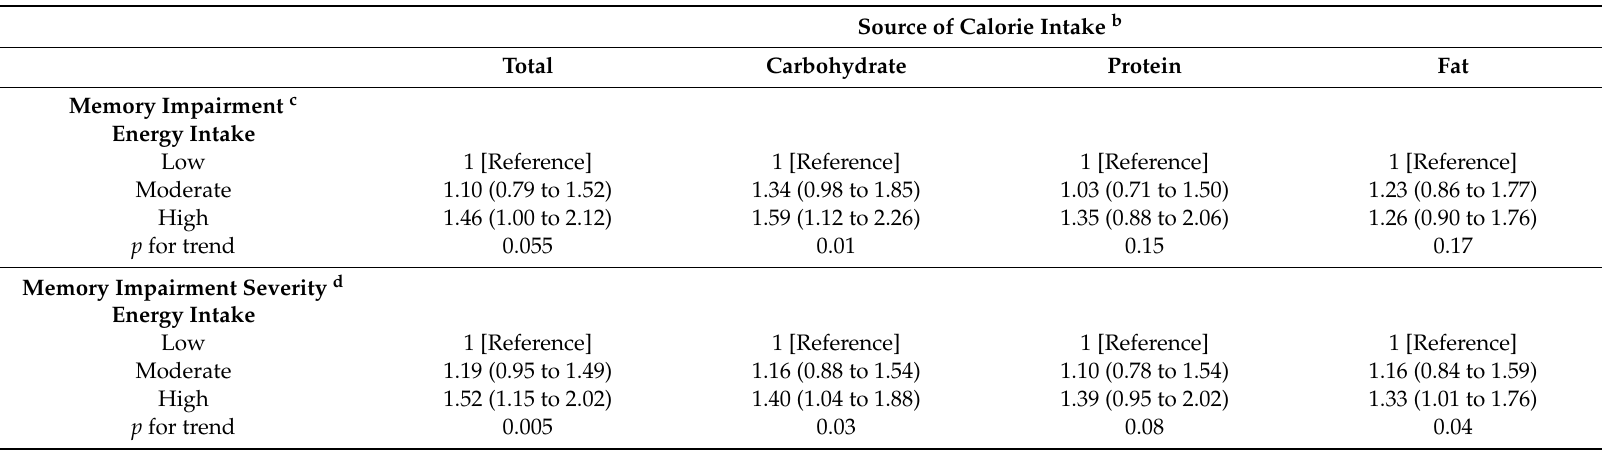
Table 3. Multivariable-adjusted Association of Source Specific Energy Intake and Memory Severity Impairment Among US Adults ≥ 60 years, NHANES 2011–2014 a